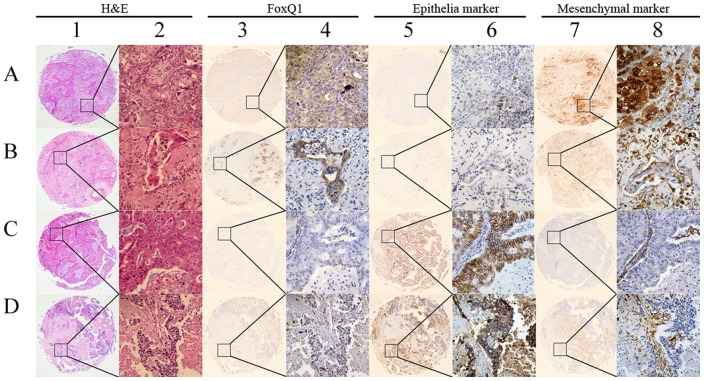
Representative IHC images showing expression of FoxQ1 and EMT-related biomarkers in TMA sections of NSCLC.(A) 1 and 2: lung squamous cell carcinoma tissue pattern with H&E staining; 3 and 4: high expression of FoxQ1; 5 and 6: loss of E-cad expression; 7 and 8: strong VIM-positive staining. (B) 1 and 2: lung adenocarcinoma tissue pattern with H&E staining; 3 and 4: positive staining for FoxQ1; 5 and 6: negative staining for MUC1; 7 and 8: up-regulated expression of S100A4. (C) 1 and 2: lung adenocarcinoma tissue with H&E staining; 3 and 4: negative IHC for FoxQ1; 5 and 6: strong immunological reaction of E-cad; 7 and 8: negative for S100A4. (D) 1 and 2: lung squamous cell carcinoma tissue with H&E staining; 3 and 4: low expression of FoxQ1; 5 and 6: high expression of MUC1; 7 and 8: weak expression of VIM. Original magnification was ×40 for 1, 3, 5 and 7; and ×400 for 2, 4, 6 and 8.